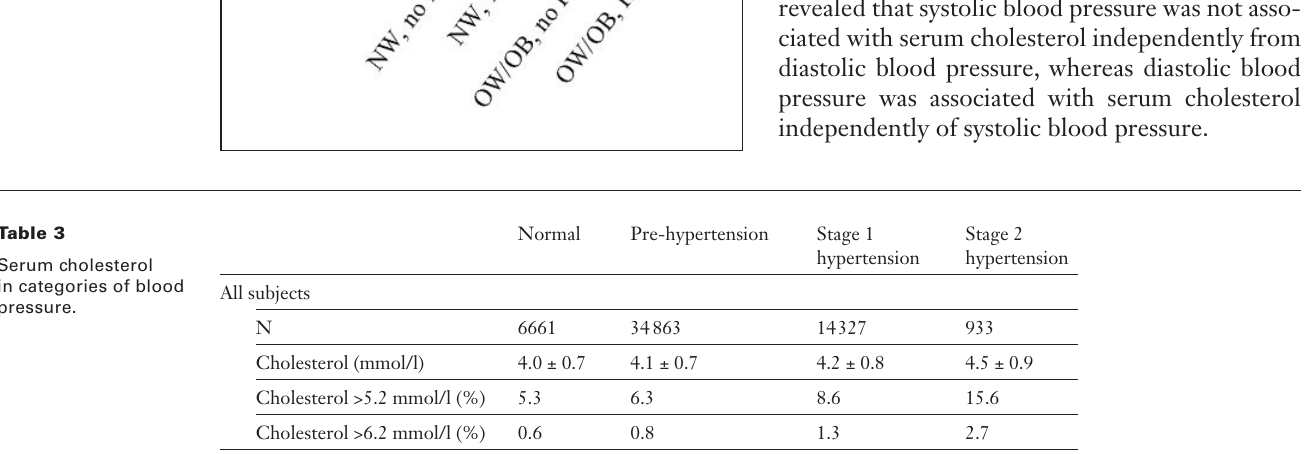
sion, OV/OB, no HT denotes the over-